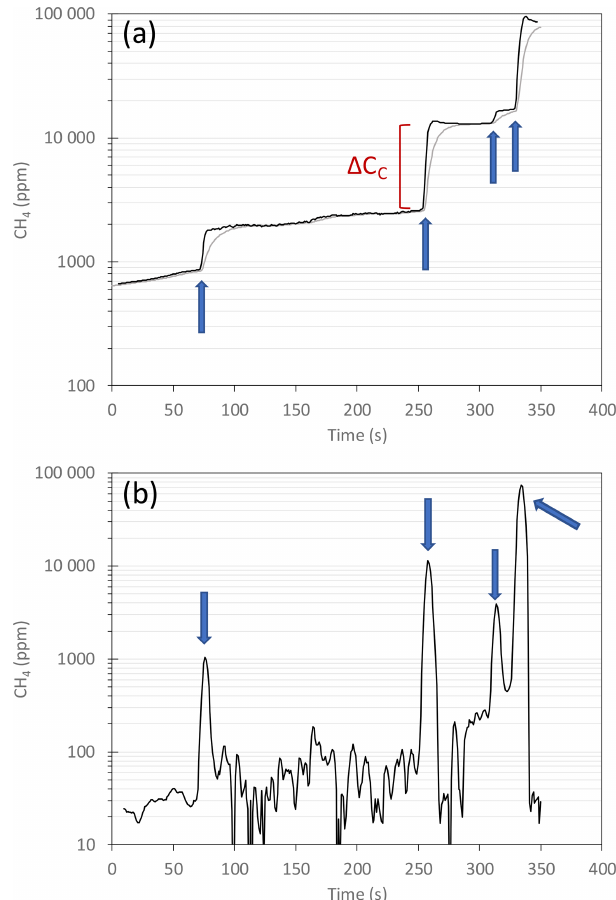
Figure 5. Typical example of (a) C D (grey solid line) and C C (black solid line) measured during a transect, and (b) instantaneous flux computed from these concentrations. Blue arrows show when large bubbles were captured by the chamber, and red marker shows an example of (cid:49)C C used to determine the CH 4 content of the bubbles (see Sect. S1). Please note the logarithmic